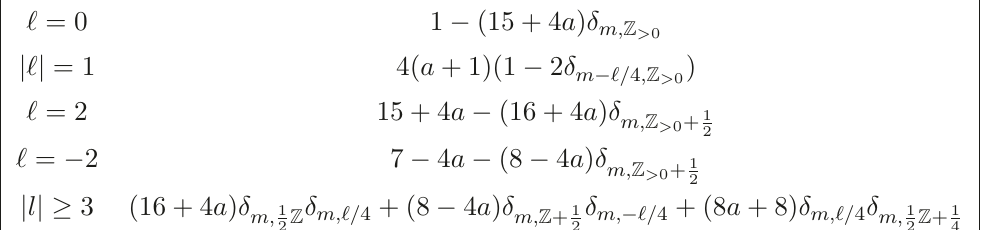
Table 5 . Values of d ( n, m, ℓ ) appearing in the elliptic genus of the symmetric orbifold of n> 0 T 4 / D n P